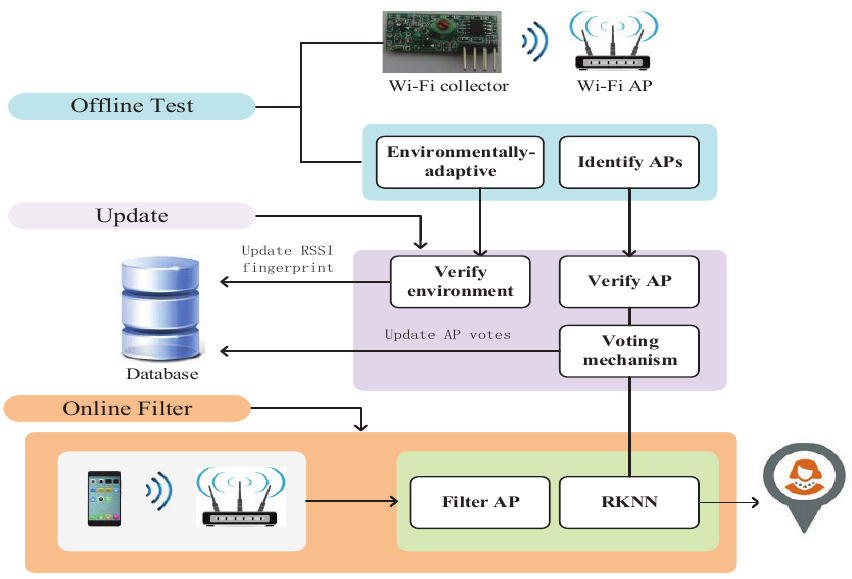
Figure 2. Reference system